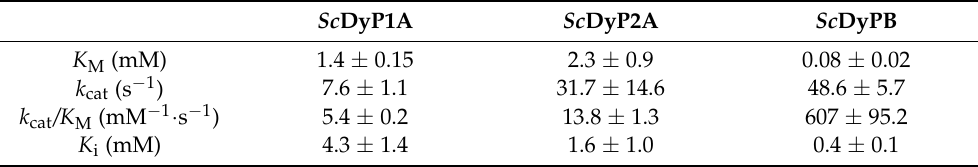
Table 3. Kinetic parameters for the oxidation of soluble model substrate ABTS by Sc DyPs. Apparent steady-state kinetic parameters were measured at pH 3.5 using 1 mM H 2 O 2 as a co-substrate. Data are average values of three independent measurements. Sc DyP1A Sc DyP2A Sc DyPB